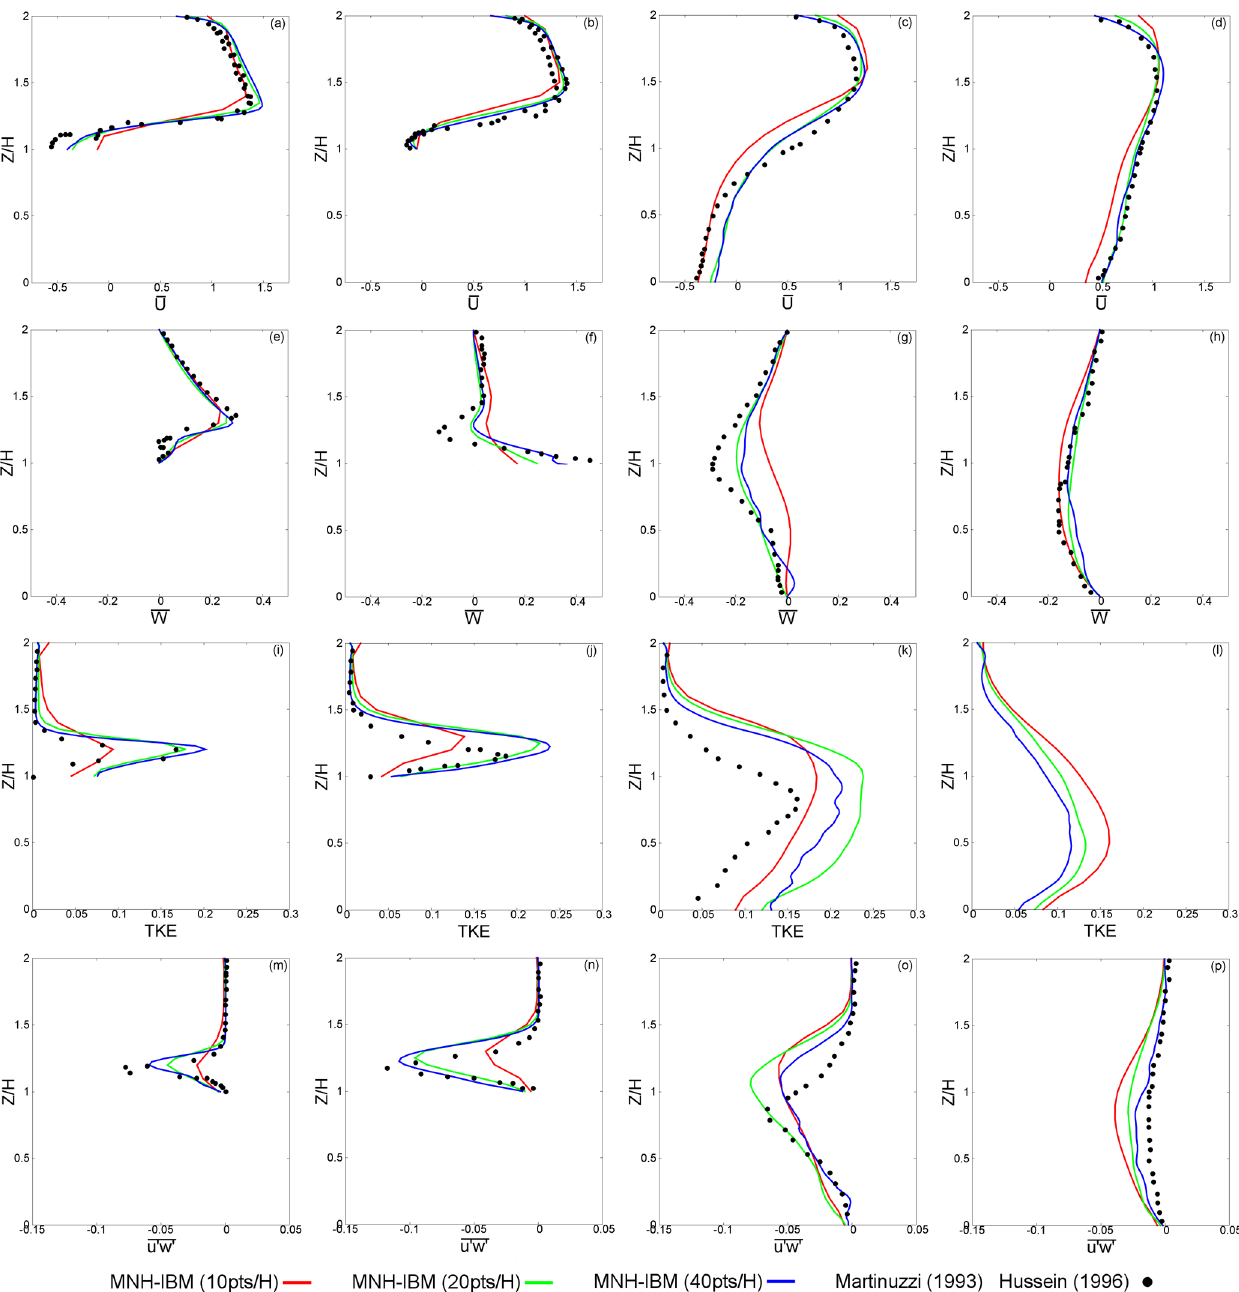
Figure 15. Mean vertical profiles of velocities (top), turbulent kinetic energy and Reynolds stress (bottom). The lines correspond to the MNH–IBM results. The symbols are the Martinuzzi and Tropea (1993) data except for TKE (Hussein and Martinuzzi, 1996). The profiles are given at four longitudinal locations: (a, e, i, m) x/H = 1 / 2; (b, f, j, n) x/H = 1; (c, g, k, o) x/H = 2; (d, h, l, p) x/H = 4. √ √ e = K tke 1 / 4 C µ ratio and the z 0 roughness dition. The u ∗ − 1 length fixed in the immersed wall model (Sect. 3.3)